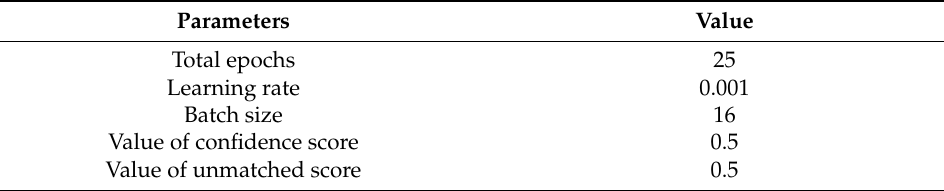
Table 2. Details of the used